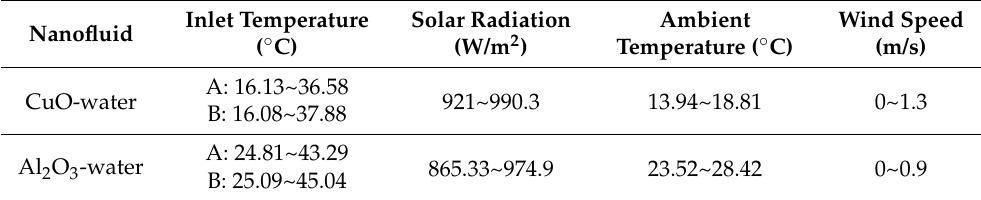
Table 5. The experimental environmental conditions.